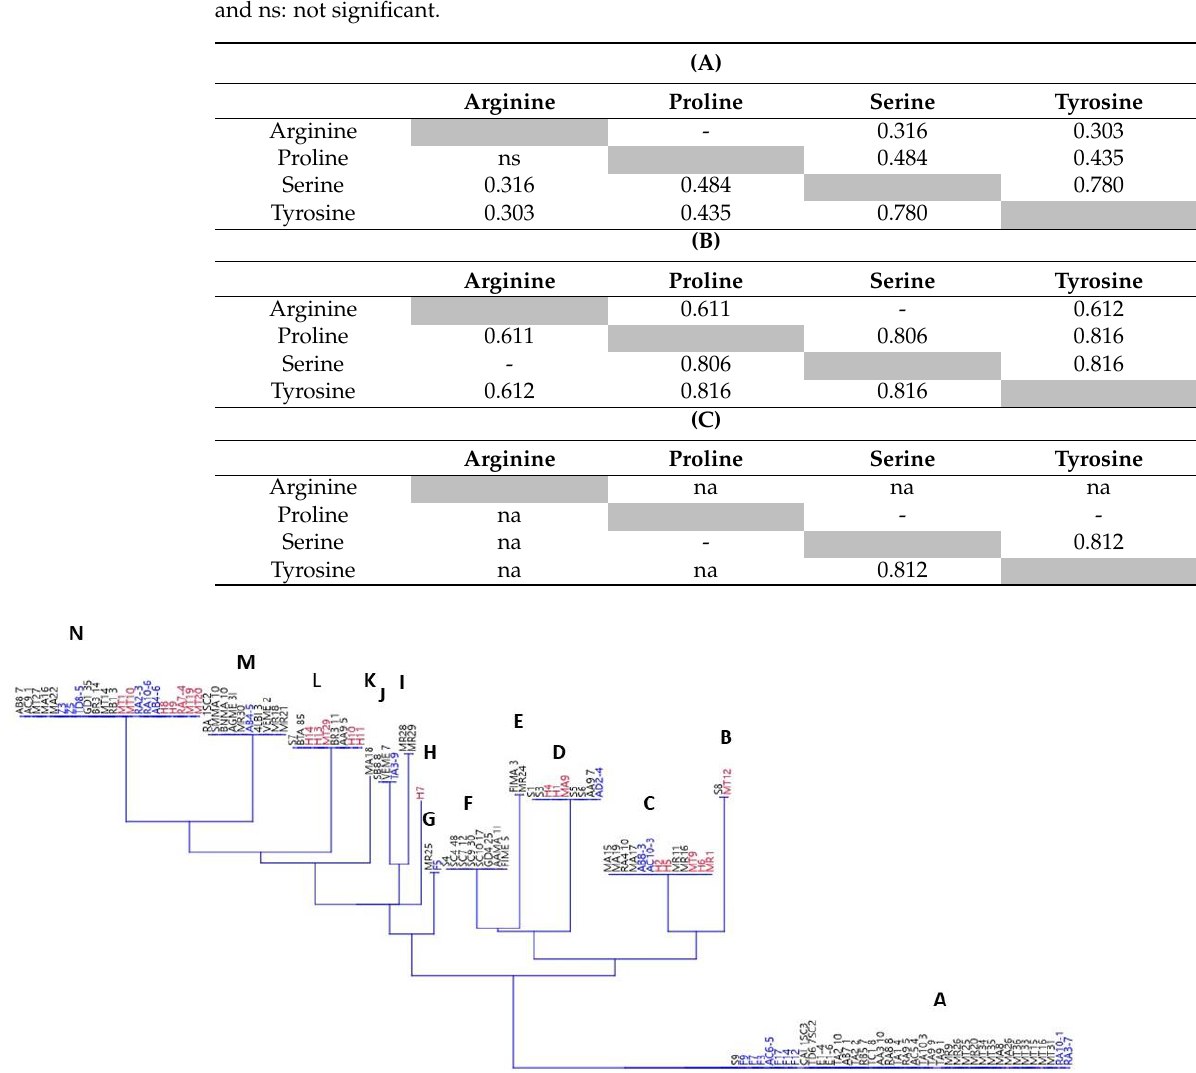
Figure 1. Neighbor joining for yeasts. The responses to amino-acid decarboxylation were used as input data for clustering. The letters on each cluster refer to the phenotypical outputs to the test, as reported in Table S1. Black, S. cerevisiae ; blue, Z. bailii ; and red, Hanseniaspora spp. Depending on the response to the decarboxylation activities, 14 different groups were found, ranging from A (positive response to all amino acids) to N (negative response to all amino acids). Group A included 41 strains (9 Z. bailli and 32 S. cerevisiae ), thus